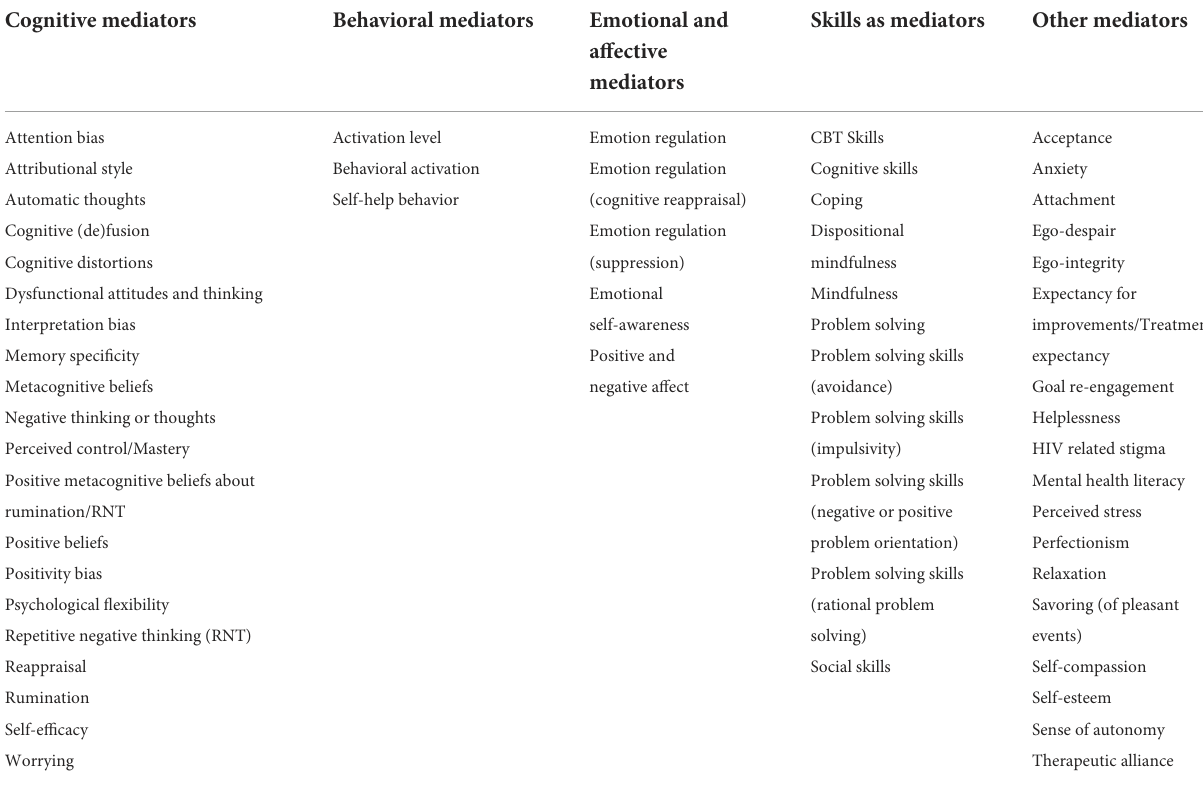
TABLE 1 List of potential